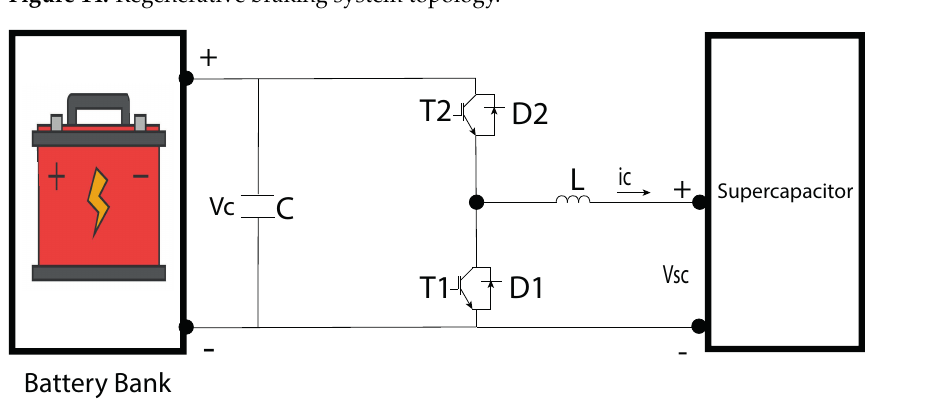
Figure 15. Buck–boost converter